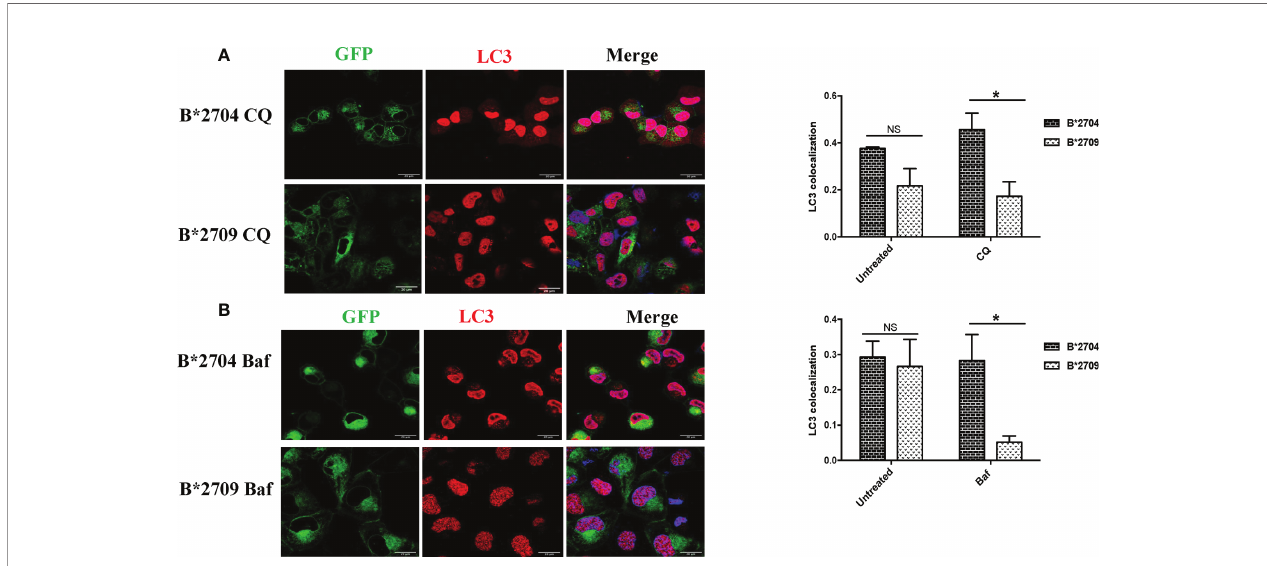
FIGURE 4 | Cells transfected with GFP fusion constructs of the disease-associated, B*2704, and non-disease-associated, B*2709, subtypes were treated with chloroquine (CQ) (A) and ba fi lomycin (Baf) (B) . Immuno fl uorescence staining was performed by confocal microscopy using anti-LC3 antibody (probed with anti-rabbit Alexa Fluor 568) (red). Nuclear staining was done using DAPI (blue). Colocalization was determined using ImageJ software through Pearson ’ s coef fi cient value. Scale bar, 20 m m. GFP, green fl uorescent protein. NS, non signi fi cant (p > 0.05); *p < 0.05.